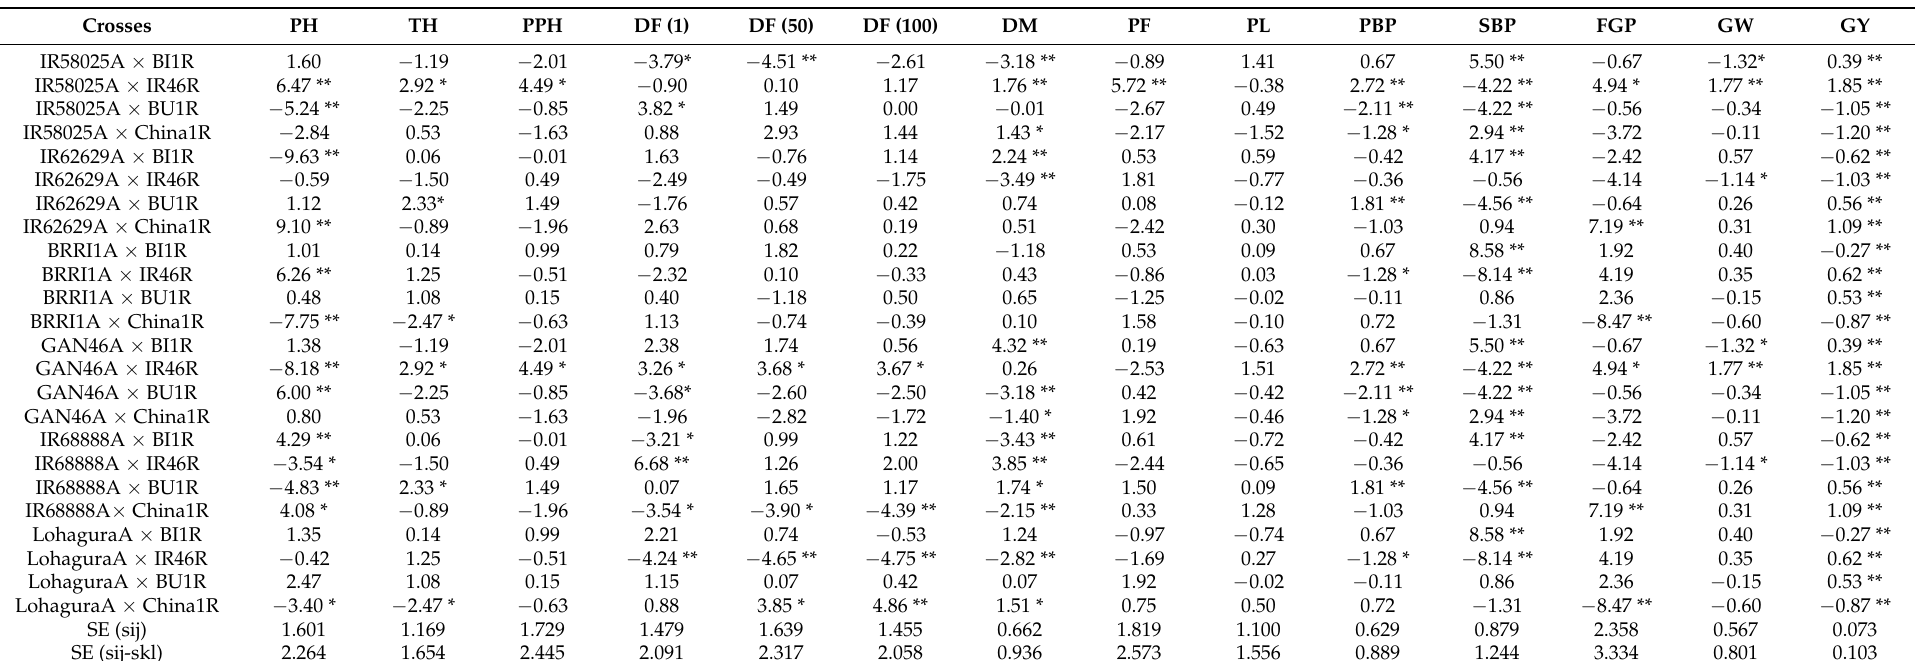
Table 4. Specific combining ability (SCA) effects of crosses for yield and its contributing